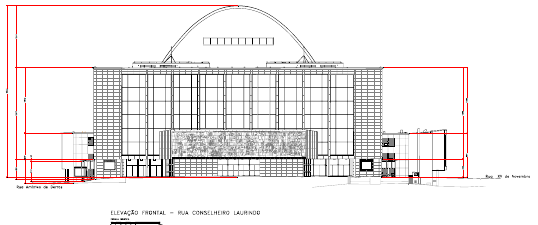
Figure 5. Front Elevation_Main Entrance with Poty Lazarotto’ concrete art panel